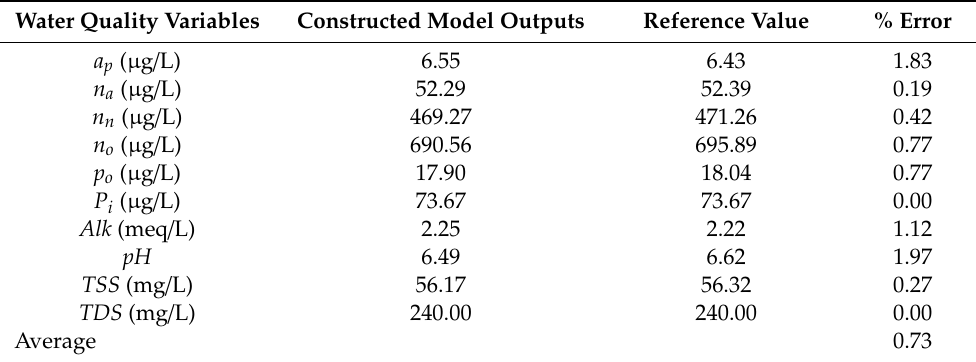
Table 5. Calibration with Qual2k for water depth 3 m.